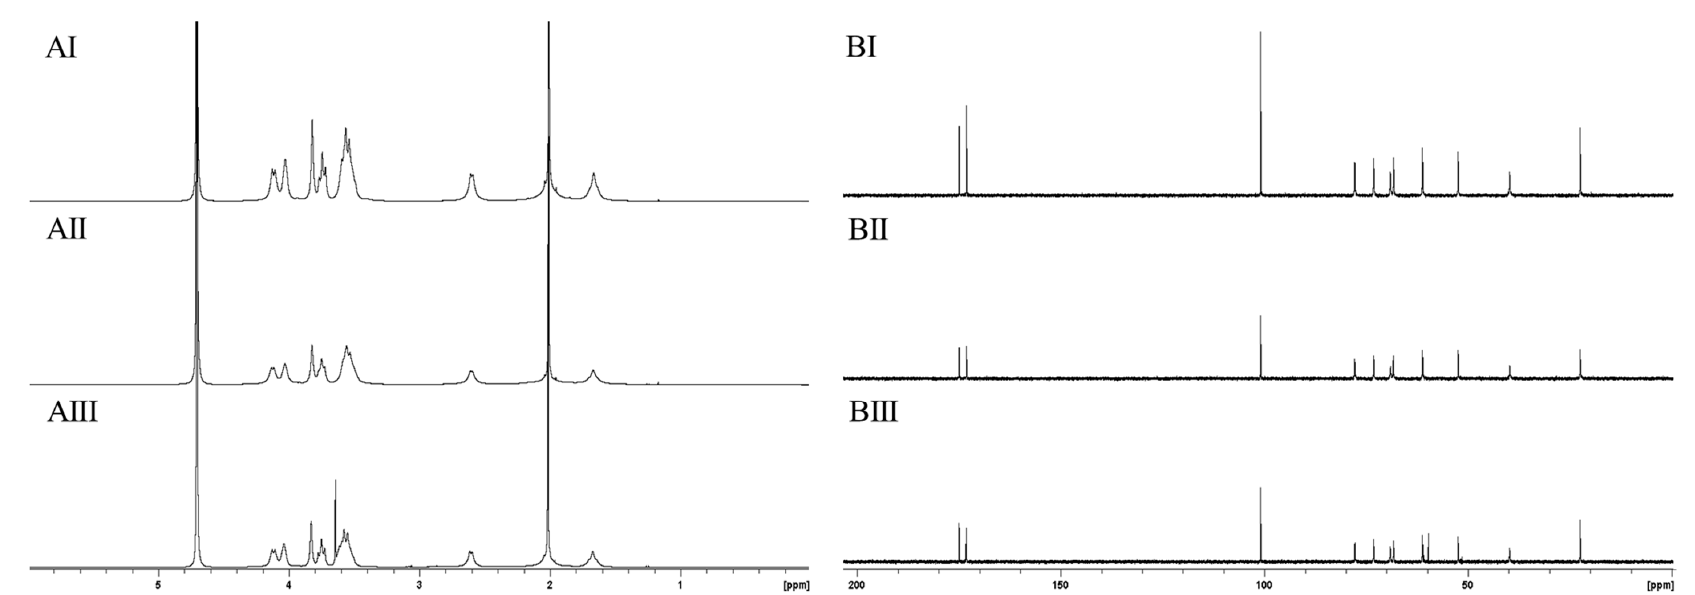
Figure 3. Comparison of the 1 H- ( A ) and 13 C- ( B ) NMR spectra of manufactured long-chain (LC) polySia with ( II ) and without ( I ) alkaline treatment for efficient removal of endotoxins. As a control, LC polySia was treated using a third approach with specific EndoTrap HD columns ( III ) under physiological conditions (pH = 7). The spectra of all three samples showed a high similarity. The NMR spectra of polySia purified using EndoTrap HD columns showed an additional signal at 60 ppm ( 13 C) and 3.6 ppm ( 1 H), indicating the presence of an unspecific impurity.